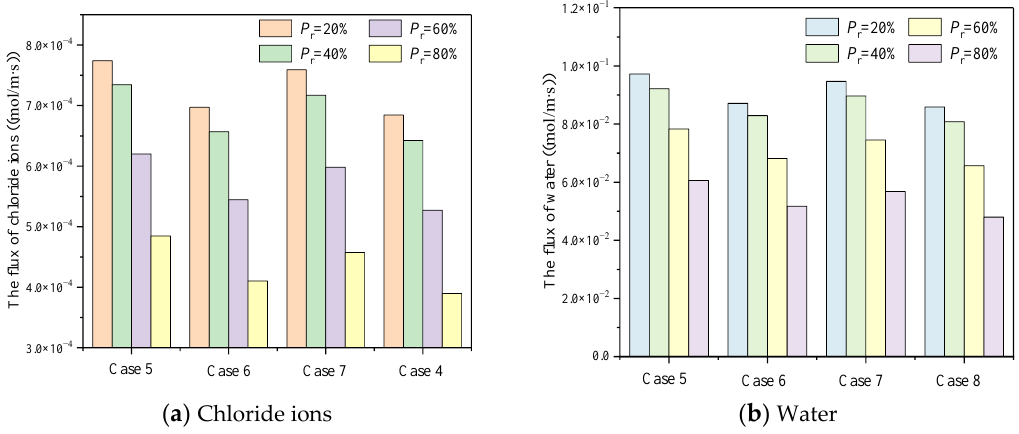
Figure 15. The influence of EDL time-varying on diffusion flux at steady state at micron scale.